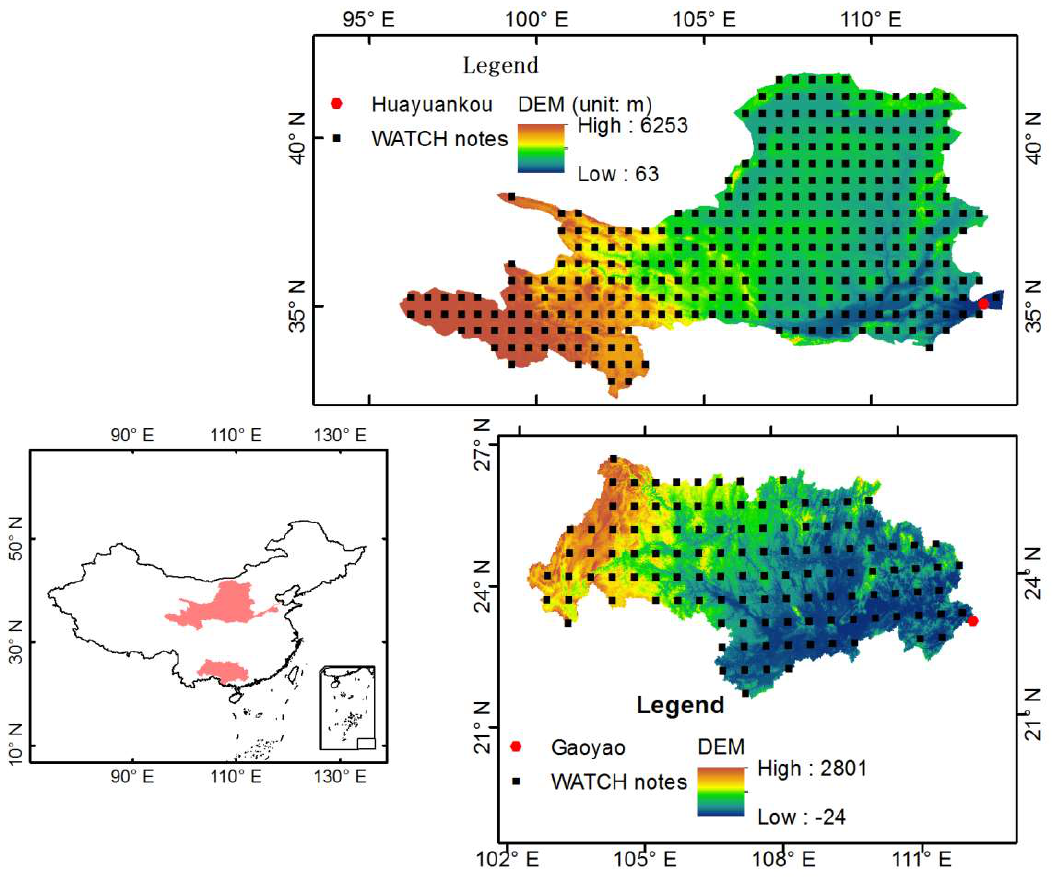
Figure 1. Locations of the studied basins in China ( lower left panel ). Overview maps of the Yellow River Basin ( upper panel ) in northern China and the Xijiang River Basin ( right lower panel ) in southern China. Grid denotes climate forcing, and red hexagons show the positions of the Huayuankou and Gaoyao hydrological